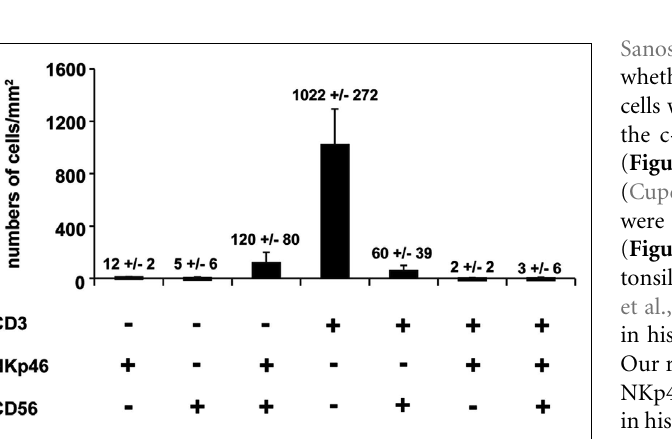
FIGURE 3 | Quantification of splenic cells expressing CD56, NKp46, or CD3. Cells with indicated phenotypes were quantified on human spleen sections. Data (mean ± SEM) are representative of three distinct individuals. Corresponding values (mean ± SEM) are indicated at the top of the corresponding bars. Counting of the indicated cell subsets was performed in 2–5 distinct areas of tissue sections.